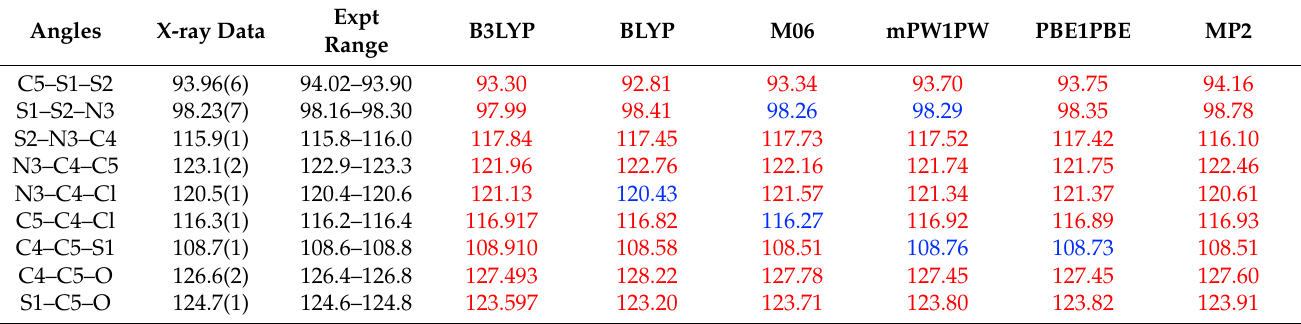
Table 4. Experimental and computational bond angles ( ◦ ) of the dithiazolone 2b a